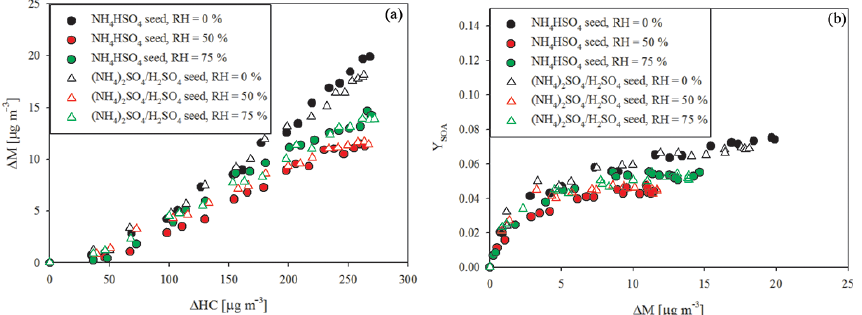
Figure 4. SOA growth curve (a) and yield curve (b) of the OH radical oxidation of 1,3,5-TMB in the presence of NH 4 HSO 4 or (NH 4 ) 2 SO 4 /H 2 SO 4 seed under variation in